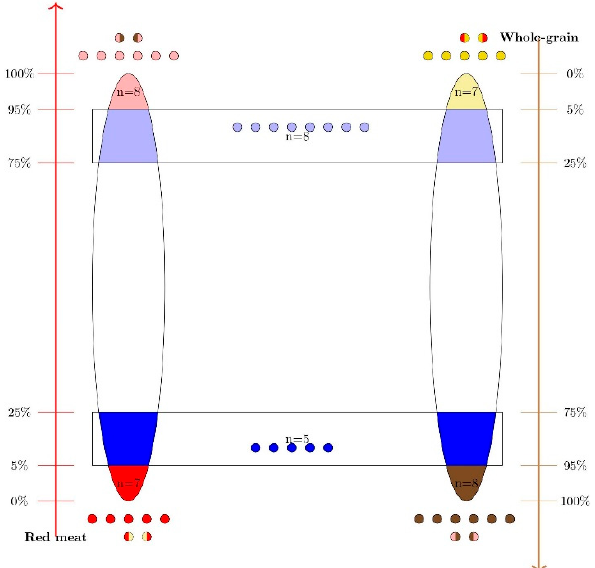
Figure 1. This figure represents the methods used in the selection of participants for assessment of mucus thickness in biopsies from colon sigmoideum based on their reported dietary intake of red meat and whole-grain. The two left and right major ellipsoids represent the 159 recruited subjects, ordered after the reported intake of red meat and whole-grain, respectively. Note that the two axes representing the proportions of the sample at the left and right side of the figure are in opposite directions. The pink and brown areas represent the upper 5th percentiles of the sample with respect to red meat and whole-grain intake, respectively. The red and yellow areas represent the lower 5th percentiles of the sample, with respect to red meat and whole-grain intake, respectively. The circles illustrate subjects found uniquely in one 5th percentile. The two-colored circles illustrate four subjects found in more than one 5th percentile simultaneously (eight two-colored circles). Furthermore, the upper rectangle included subjects located simultaneously at the upper red meat and lower whole-grain quartiles ( n = 8). The lower rectangle included subjects located simultaneously at the lower red meat and upper whole-grain quartiles ( n = 5). The sum of these subjects ( n = 39 was selected as the targeted study population.